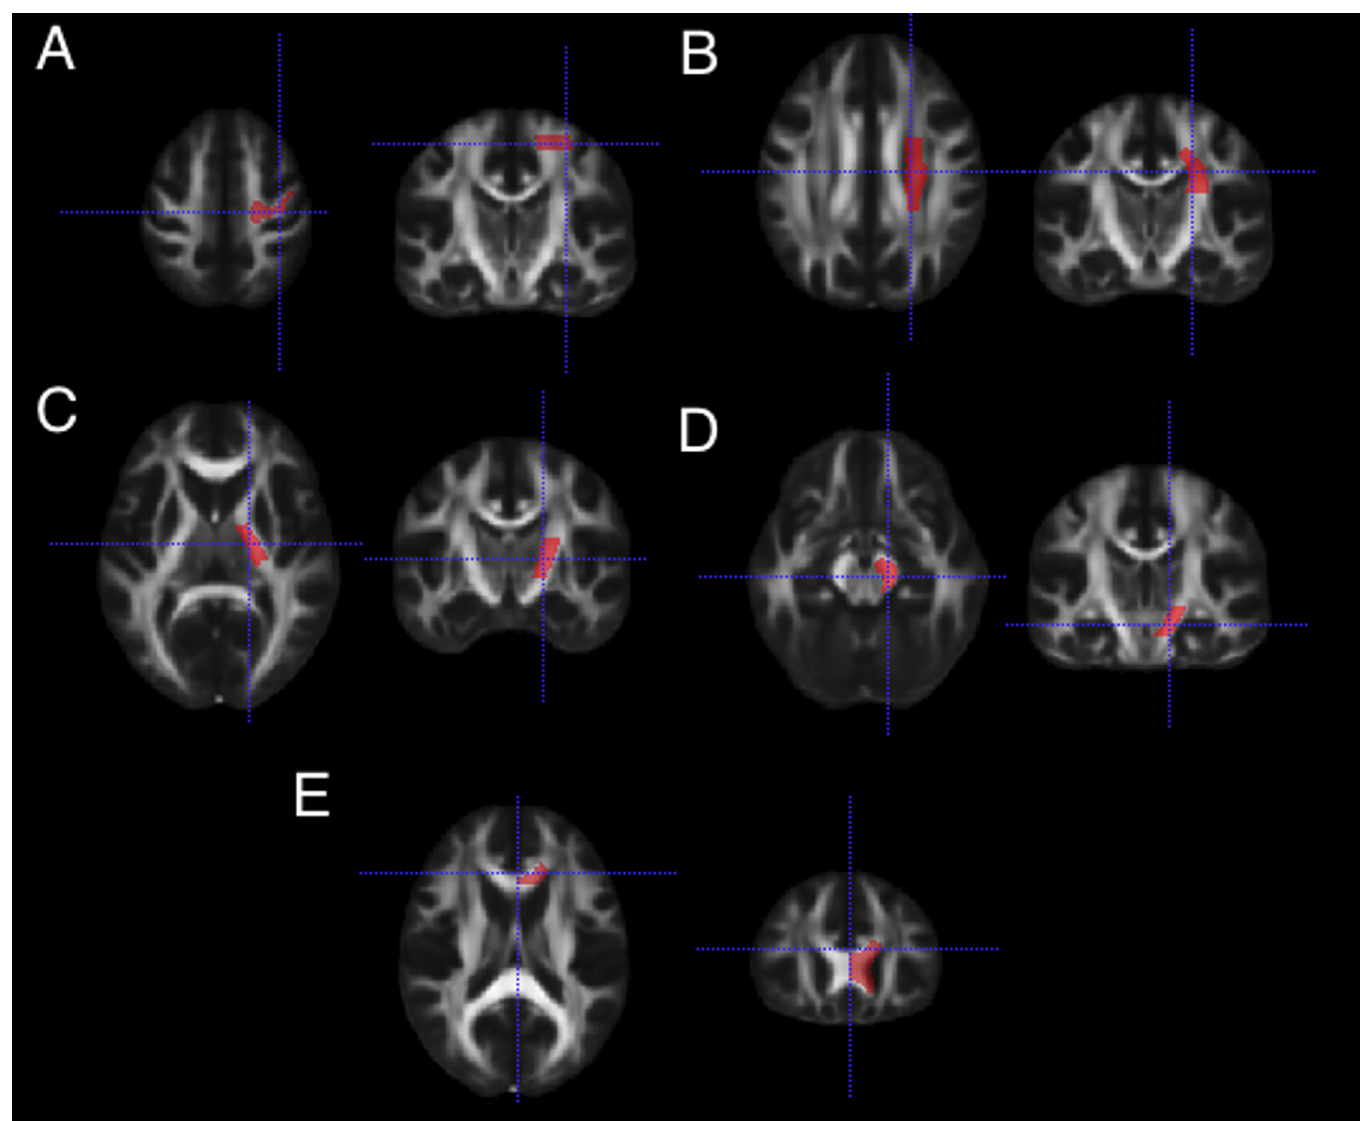
Fig 1. Regions-of-Interest for extraction of diffusion parameters. A preview of the Regions-of-Interest (in red) used in the analysis overlaid on the FMRIB58 fractional anisotropy standard space image. (A) White matter underlying the pre-central gyrus. (B) Corona Radiata. (C) Posterior Limb of Internal Capsule (D) Cerebral Peduncles (E) Genu of the Corpus